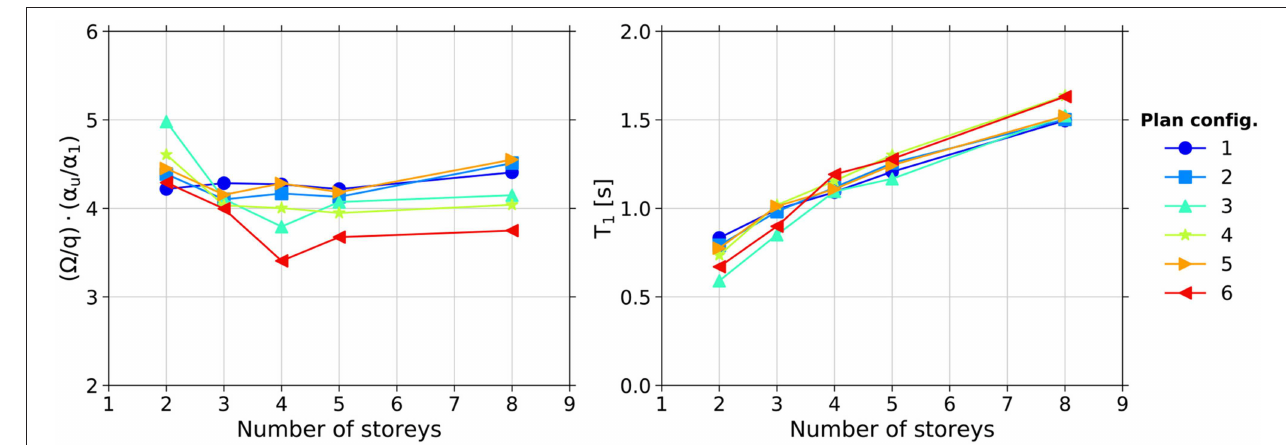
FIGURE 3 | Overstrength levels and periods of vibration of the archetype suite.